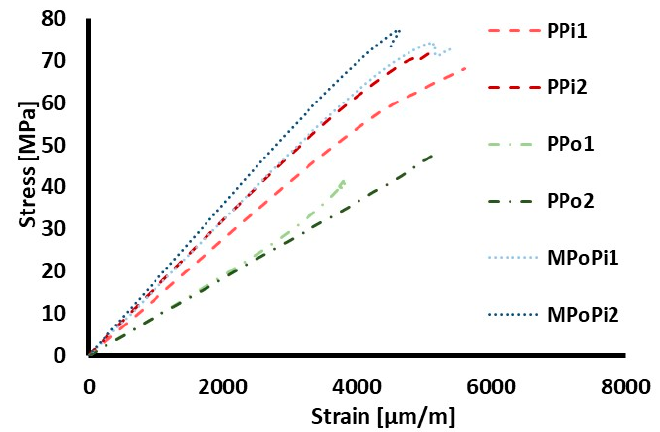
Figure 8. Stress versus strain for the tensile strain gauge (bottom face) for all the samples.